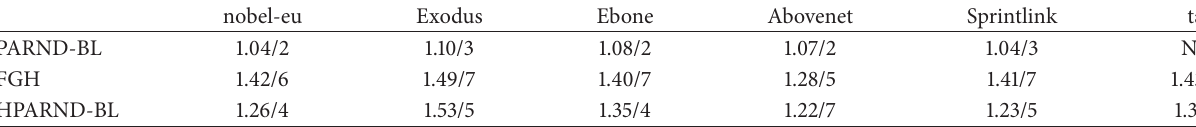
Table 11: Number of paths per flow (Avg/Max)—cubic curve. nobel-eu